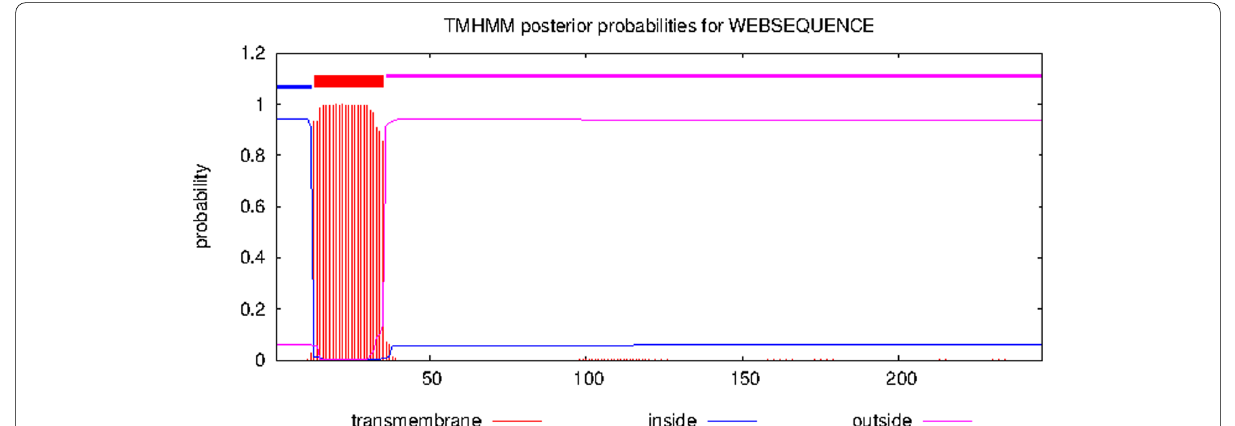
Fig. 2 Graphical output of a transmembrane domain between 13 to 37 amino acids of NHP1 protein predicted using the server